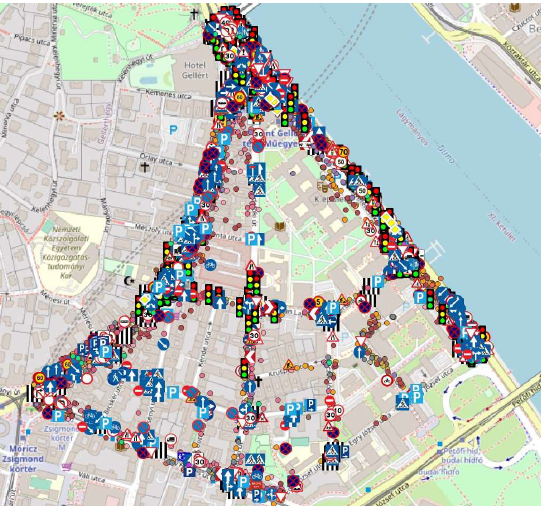
Figure 4. The Mapillary-detected objects in the pilot site The geospatial analyses were executed in QGIS v3.18 Zürich.